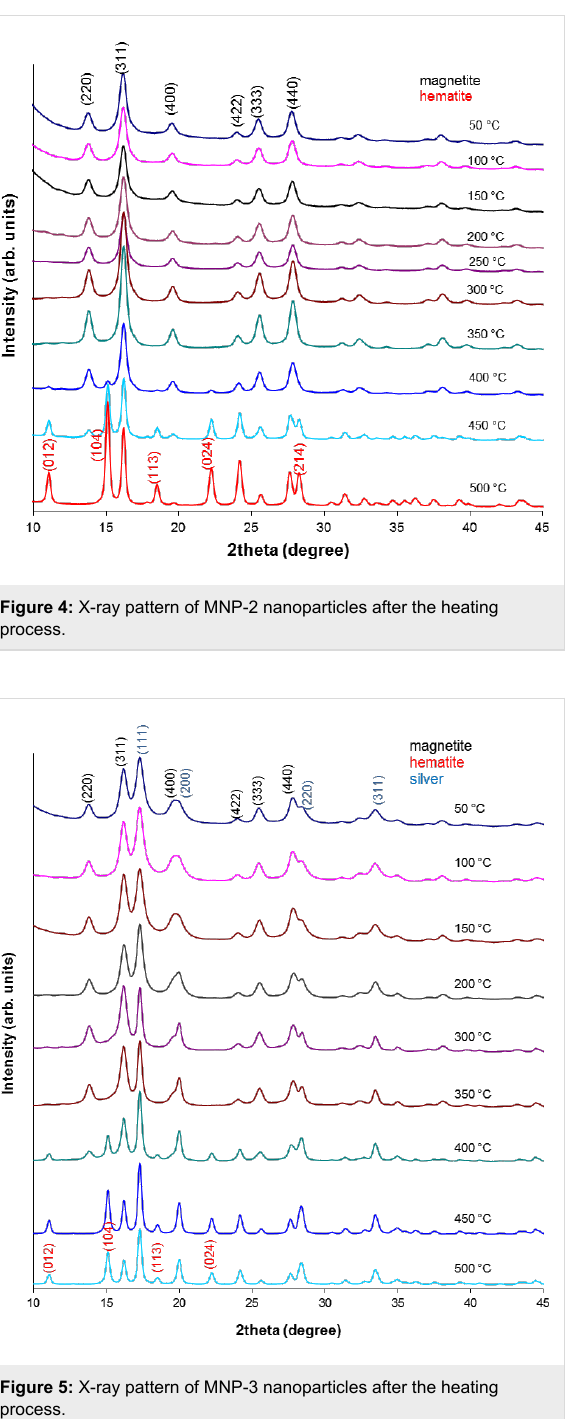
Here, in each set of XRD patterns, the well-defined crystalline structure of magnetite and/or maghemite with indexes ( hkl ) ascribed to (220), (311), (400), (422), (333) and (440) [12,29] are observable. MNP-1 nanoparticles do not show any signifi- cant amount of additional structure up to 400 °C and therefore no additional patterns are presented. At 450 °C and 500 °C